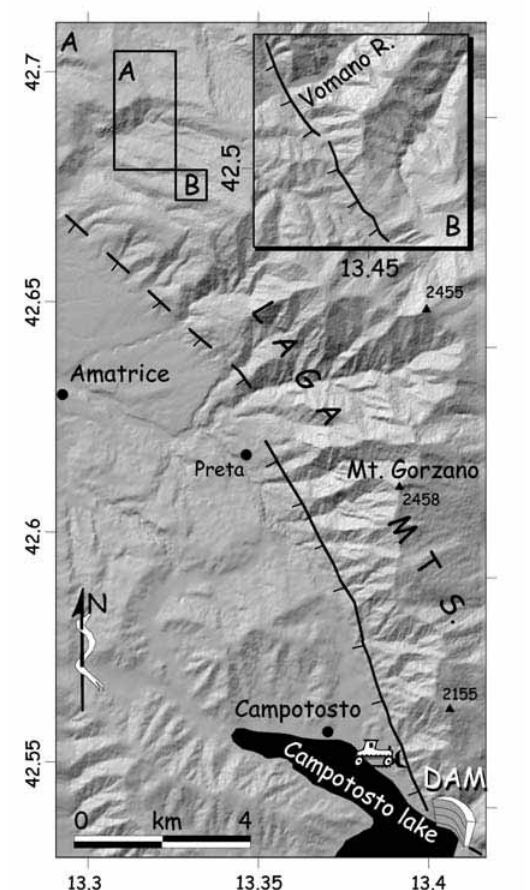
Fig. 8. Map of the Laga Mts. Fault. Clear evidence of Late Pleistocene-Holocene activity can be detect- ed along most of the fault, apart from the north- ern portion (dashed) which was considered not active by Galadini and Messina